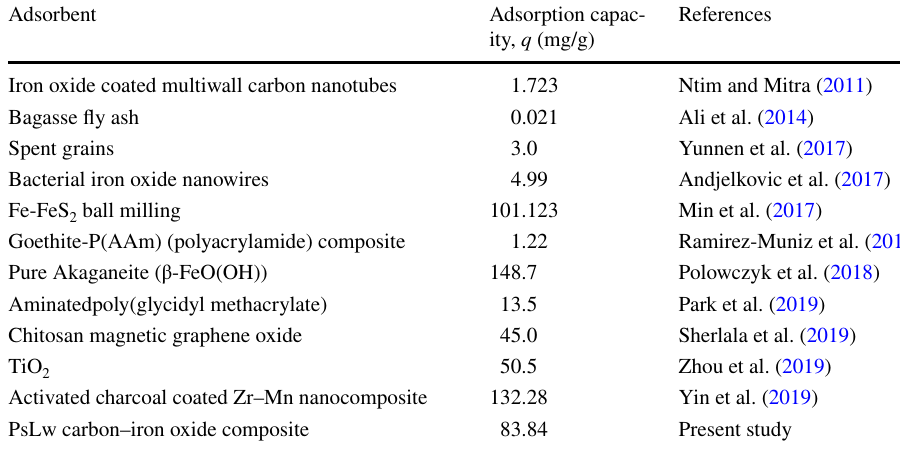
Table 6 Adsorption capacity of different